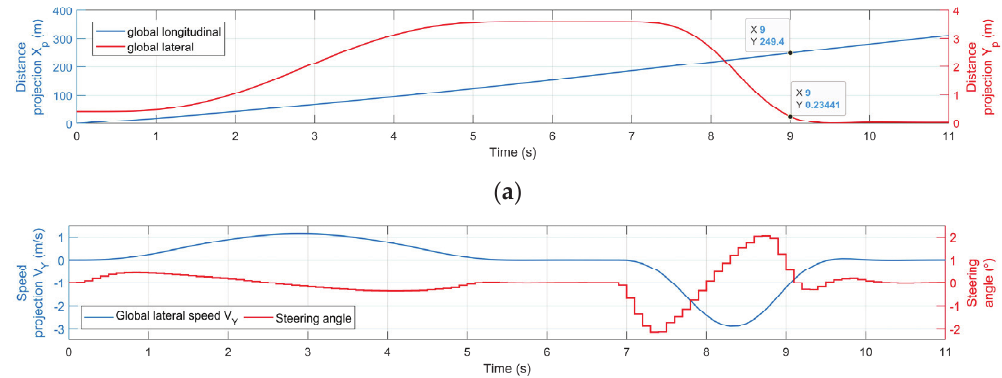
Figure 10. Simulation results of vehicle steering control prognosis during overtaking: ( a ) Global displacements; ( b ) steering control and lateral speed